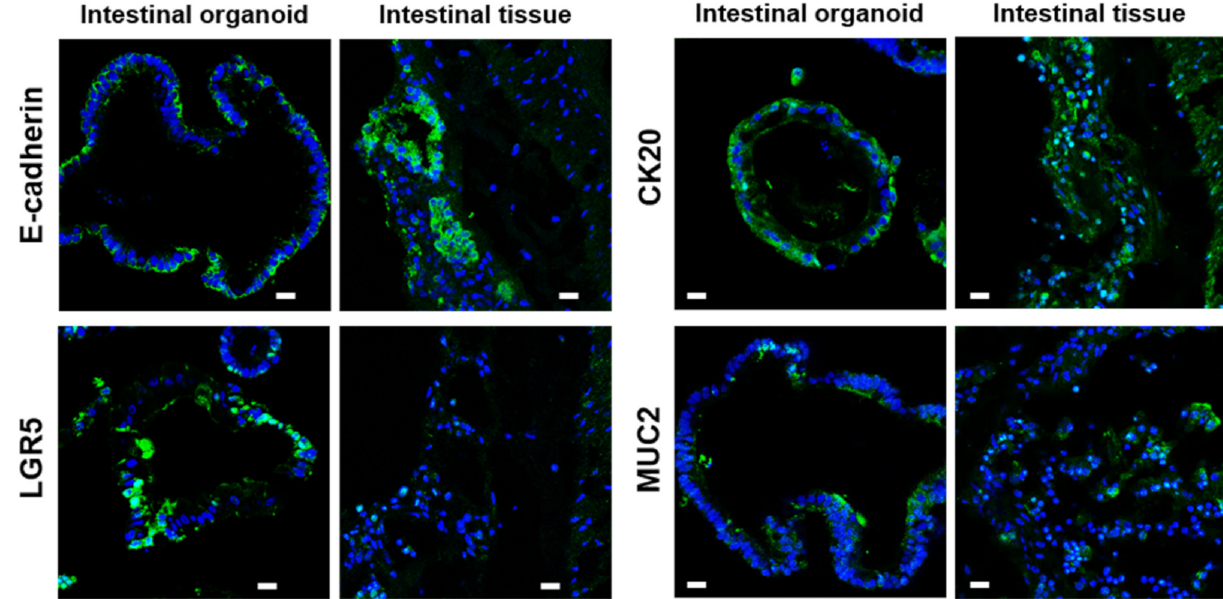
Figure 2. Characterization of the cellular components of the intestinal organoids from rousette bats. Expression of an epithelial cell marker, E-cadherin, an intestinal stem cell marker, LGR5, a mature enterocyte marker, CK20, and an intestinal goblet cell marker, MUC2. Scale bar: 50 µ